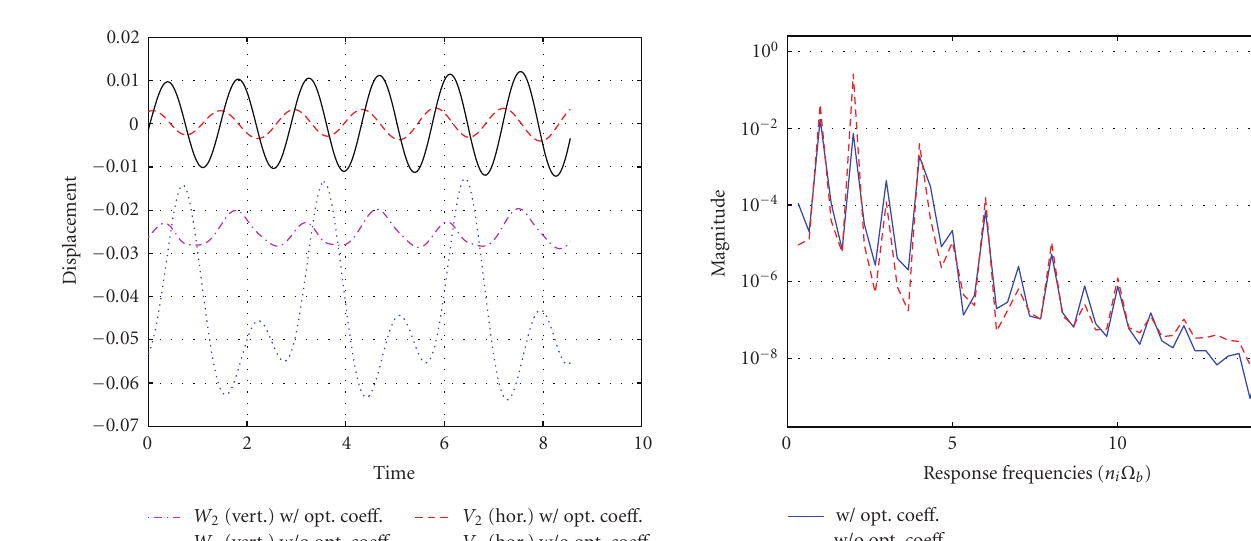
Figure 11: Response plots at Ω b = 3 . 0, bearing 1.